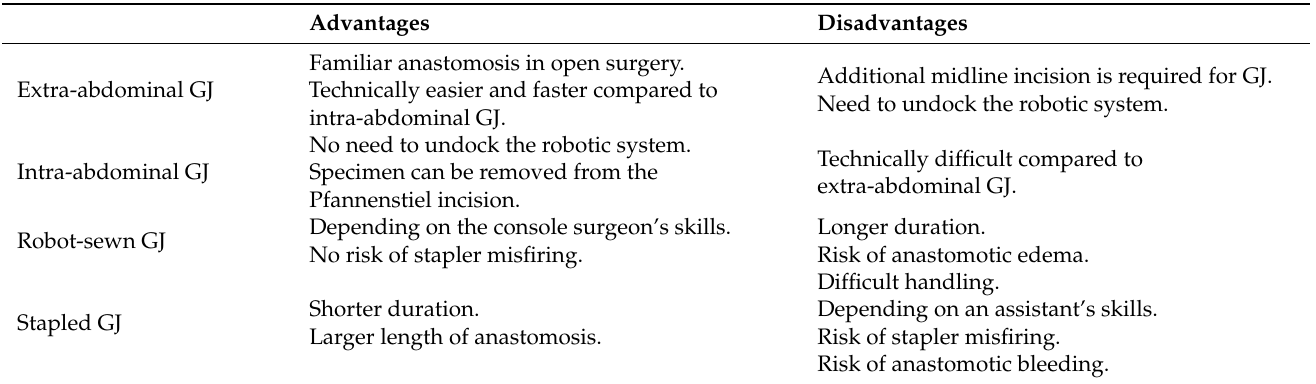
Table 3. Advantages and disadvantages of various gastrojejunostomy anastomoses in robotic pancre-